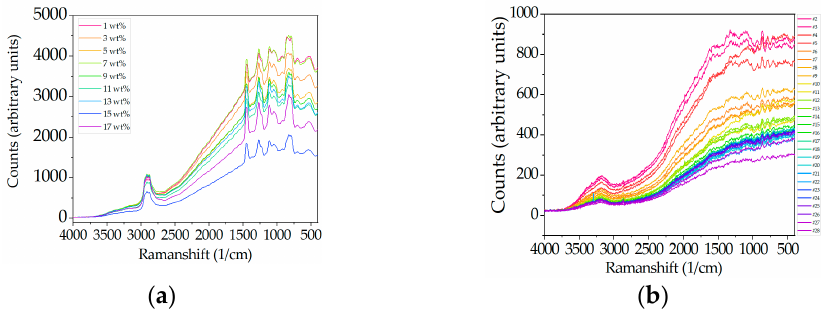
Figure 6. Raman spectral raw data for precipitation ( a ) and dissolution ( b ).